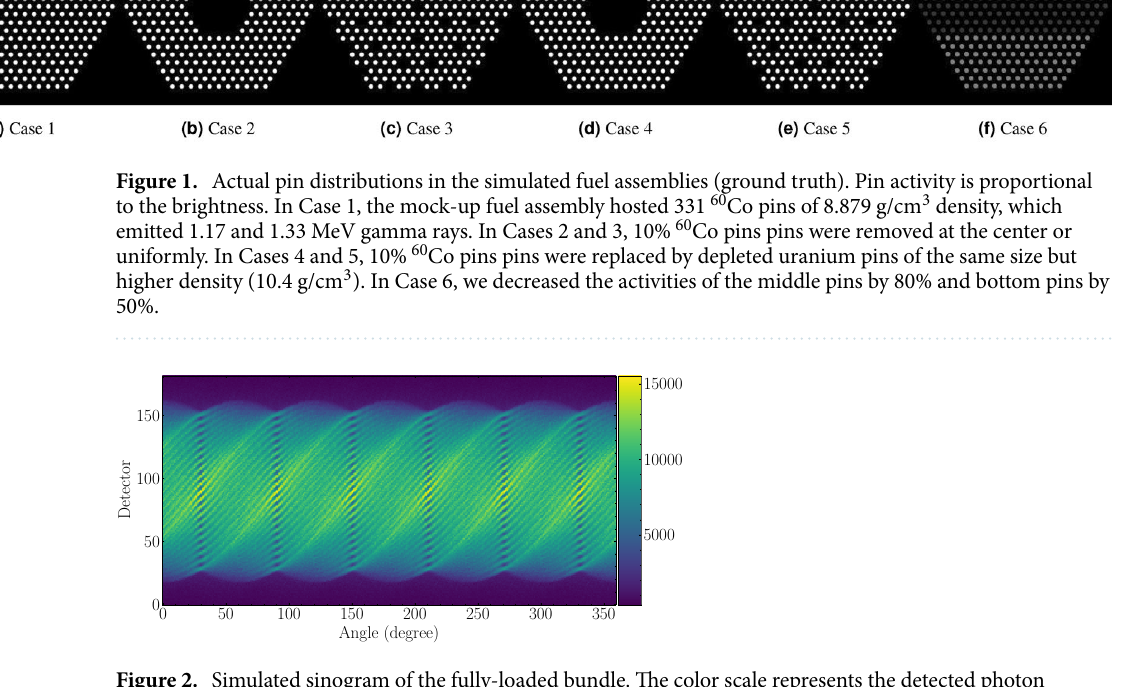
Figure 2. Simulated sinogram of the fully-loaded bundle. The color scale represents the detected photon counts. The periodicity of the singogram resulted from the hexagonal symmetry of the simulated fuel